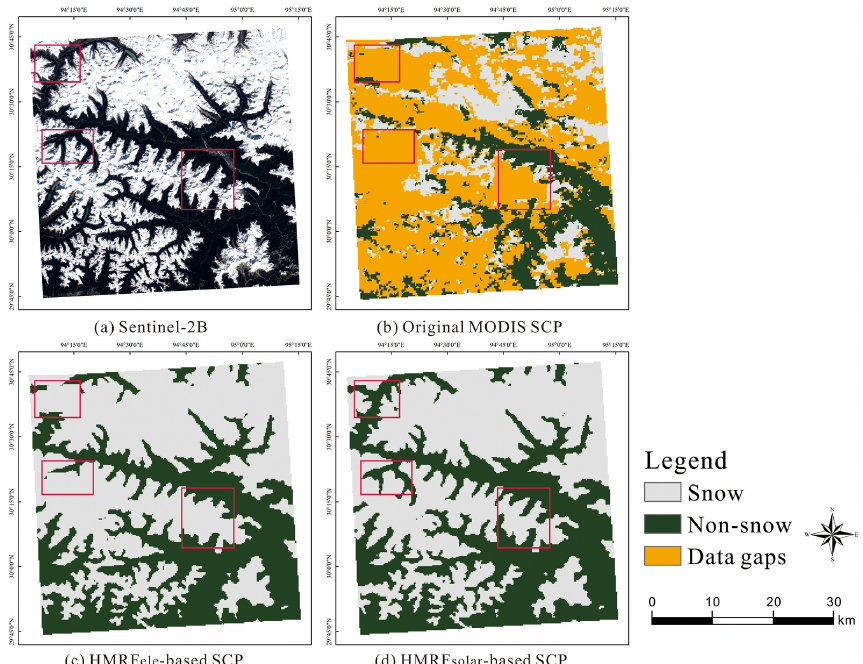
Figure 8. Comparison between true-color Sentinel-2B imagery (a) , original MODIS snow products (b) , HMRF ele -based snow products (c) , and HMRF solar -based snow